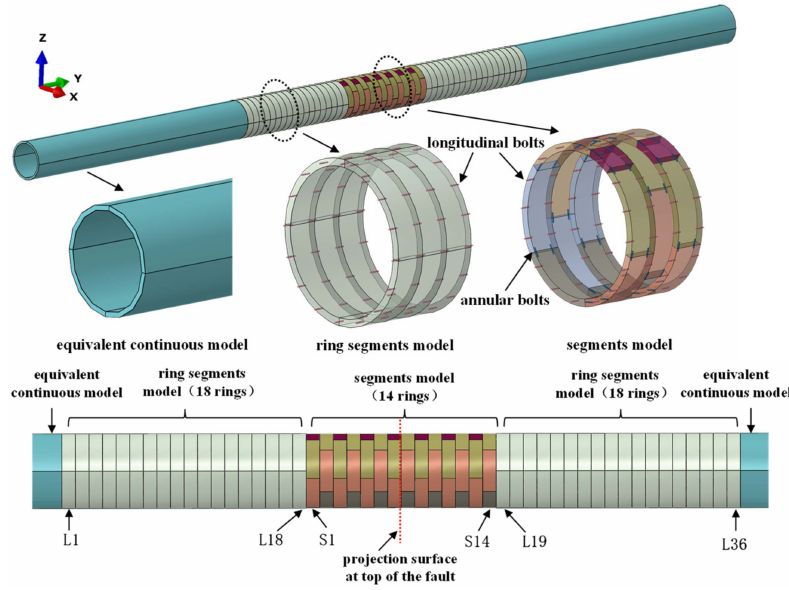
Figure 4. Numerical model of the segmental tunnel.